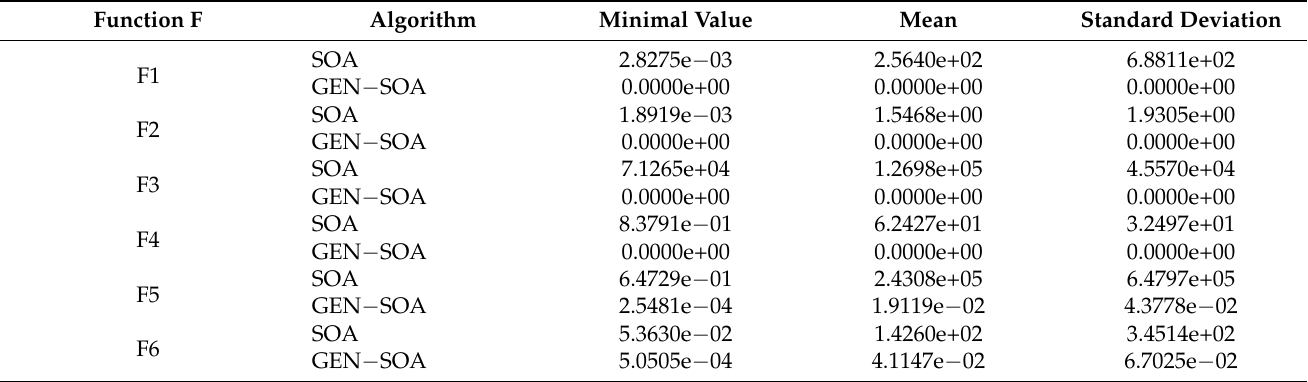
Table 1. A comparison of the GEN − SOA and SOA operation